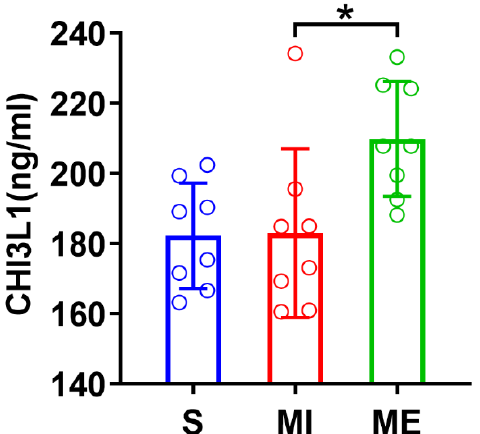
Figure 5. Quantified levels of CHI3L1 from rat serum samples ( n = 8/group) assessed by ELISA. Abbreviations : S, sham control group; MI, myocardial infarction group; ME, post ‐ MI exercise trained group. Symbol * indicates p < 0.05 when comparing groups MI and ME.